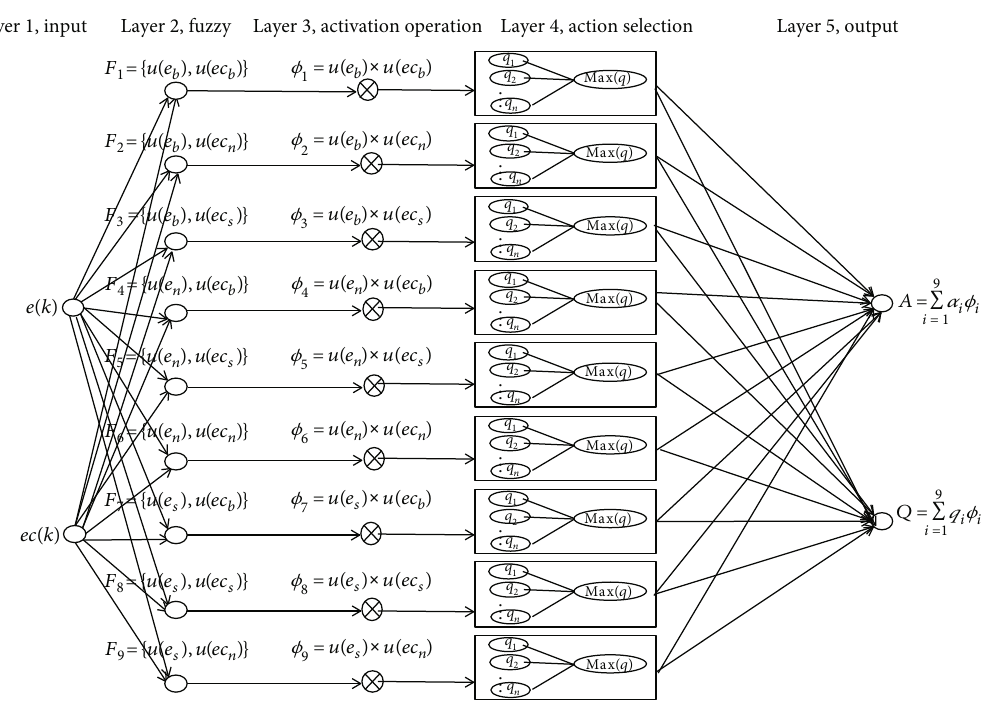
Figure 8: Structure of fuzzy neural network Q-learning based on RBF.